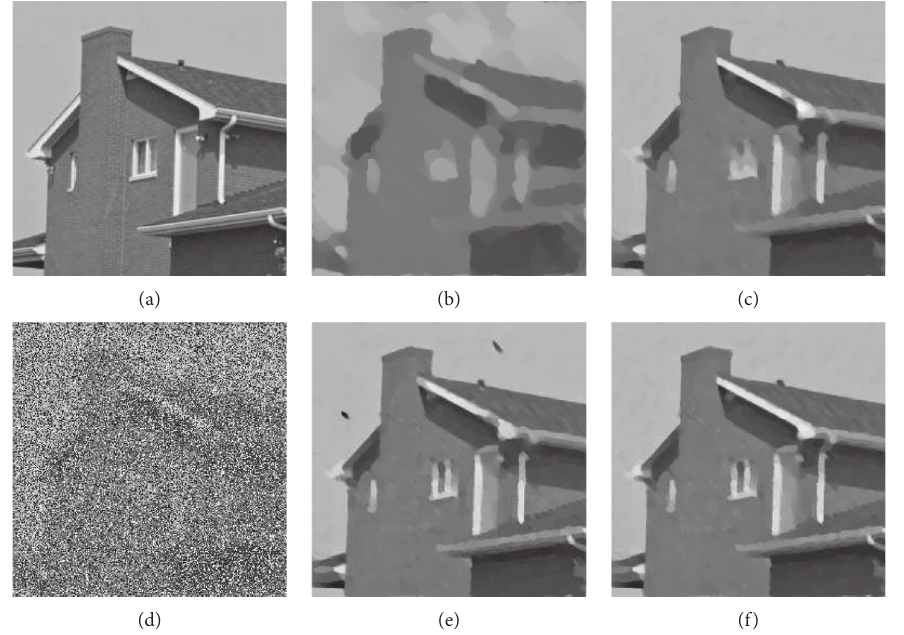
Figure 12: The recovery results (House 256) by Motion blur with 70% RV noise. (a) Original. (b) TVL1, PSNR � 20.4153. (c) TVSCAD, PSNR � 25.1866. (d) Motion blur (lev � 0.7). (e) TVLog, PSNR � 25.9254. (f) LogTVSCAD, PSNR � 27.1259.